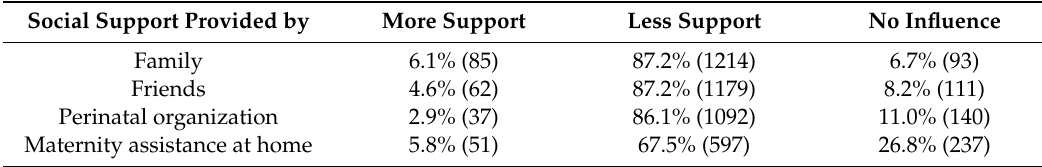
Table 3. Impact of the coronavirus pandemic on the extent of social support during lactation. Social Support Provided